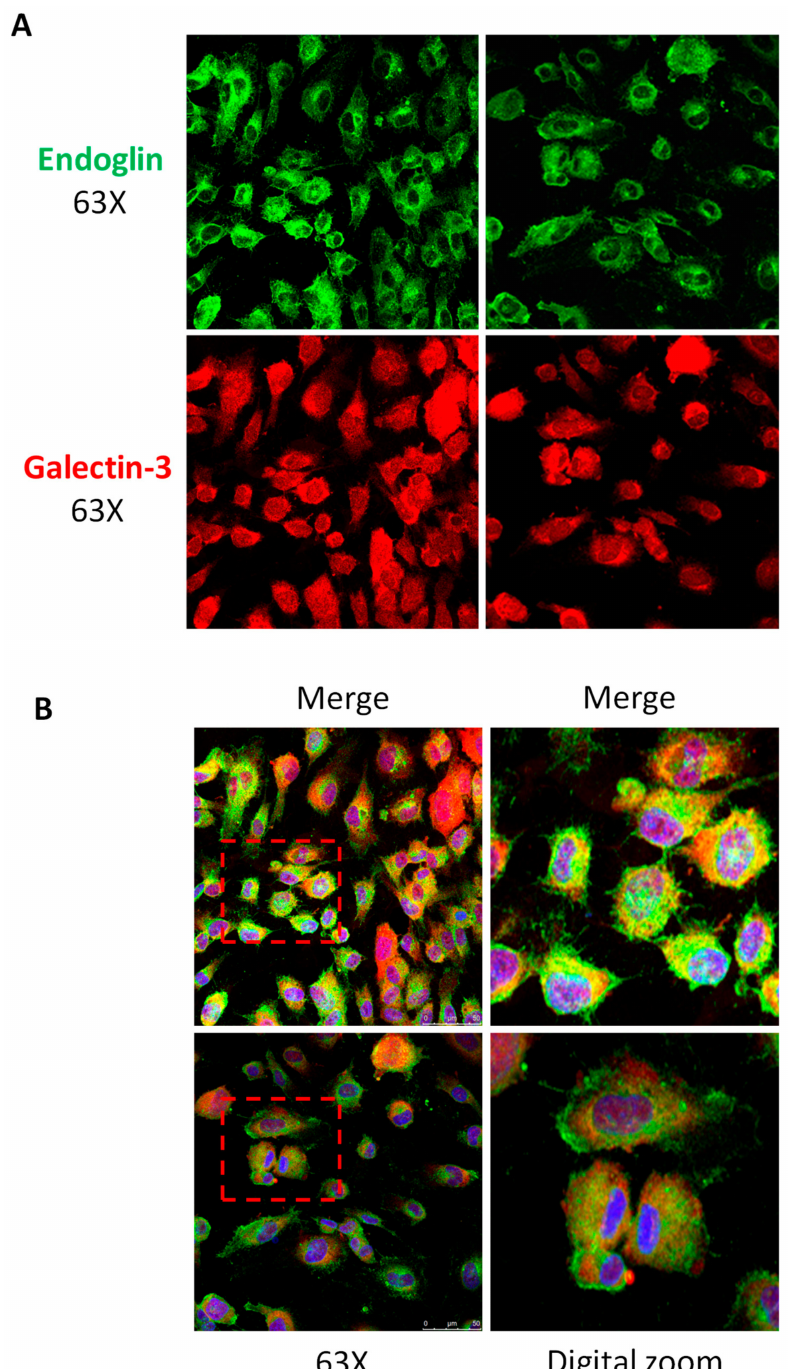
Figure 2. Galectin-3 and endoglin co-localize in human endothelial cells. Human umbilical vein-derived endothelial cell (HUVEC) monolayers were fixed with paraformaldehyde, permeabilized with Triton X-100, incubated with the mouse mAb P4A4 anti-endoglin, washed, and incubated with a rabbit polyclonal anti-galectin-3 antibody (PA5-34819). Galectin-3 and endoglin were detected by immunofluorescence upon incubation with Alexa 647 goat anti-rabbit IgG (red staining) and Alexa 488 goat anti-mouse IgG (green staining) secondary antibodies, respectively. ( A ) Single staining of galectin-3 (red) and endoglin (green) at the indicated magnifications. ( B ) Merge images plus DAPI (nuclear staining in blue) show co-localization of galectin-3 and endoglin (yellow color). Representative images of five di ff erent experiments are